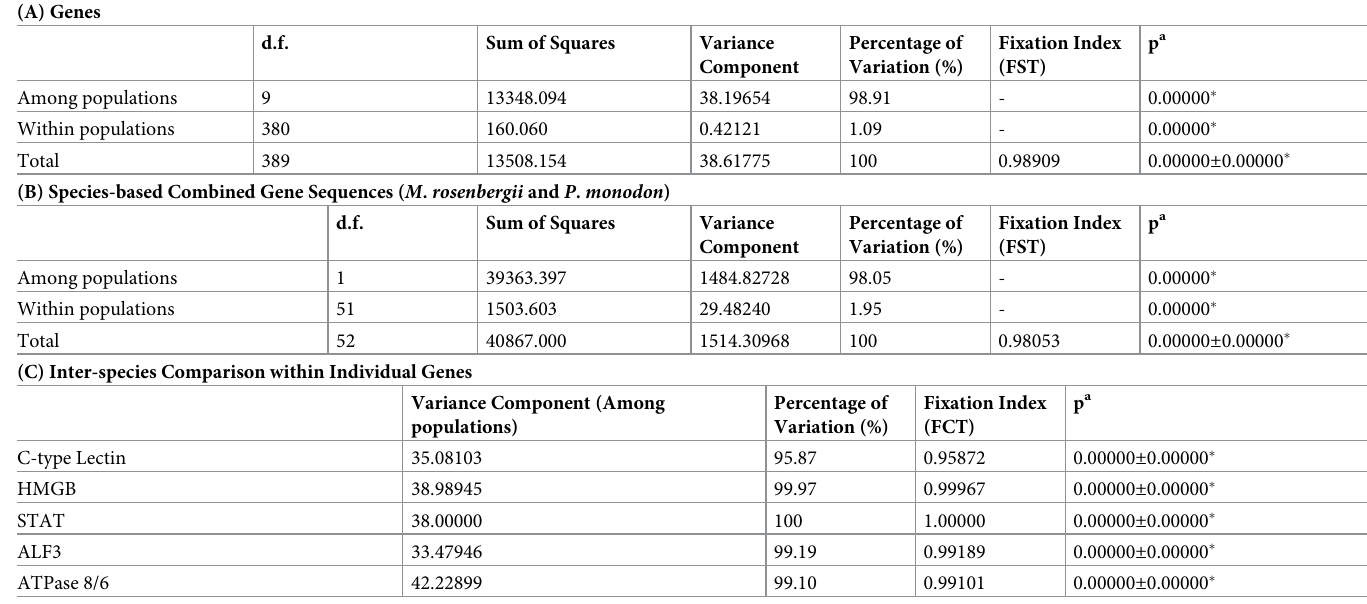
Table 1. Measures of genetic differentiation based on analysis of molecular variance (AMOVA) approach using Arlequin software. (A) Genes